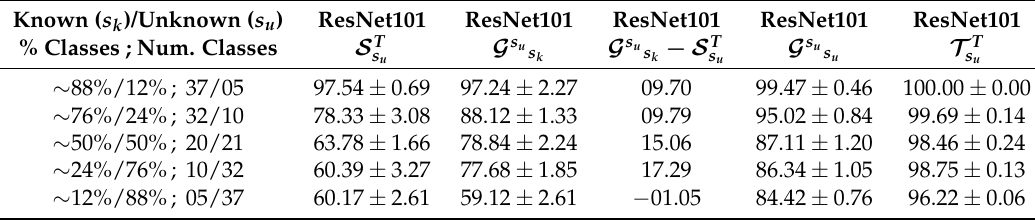
Table 7. Experiments to support Q1 analogously to Table 6, but using